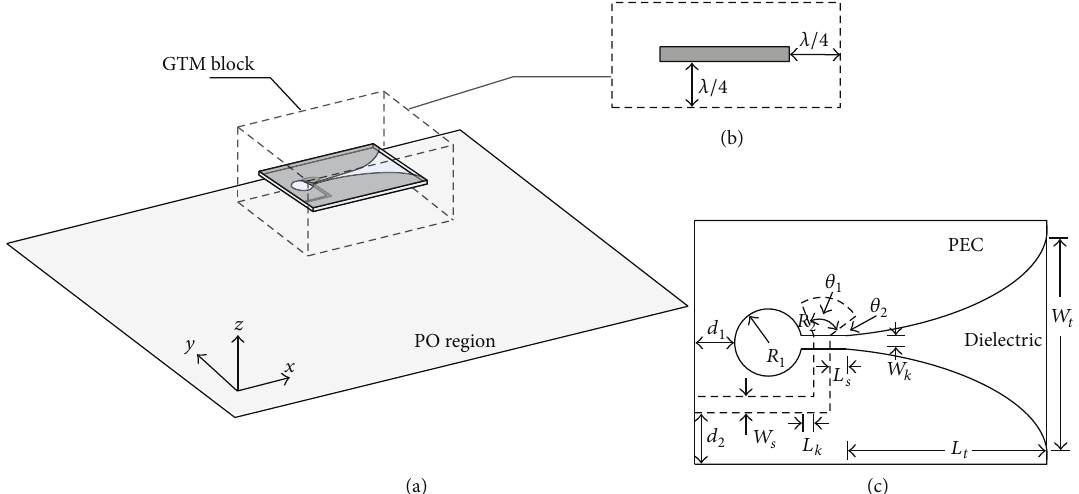
Figure 5: (a) The sketch of the antenna on the PEC plate and (b) side view of the GTM block. (c) Geometry parameters of the Vivaldi antenna.